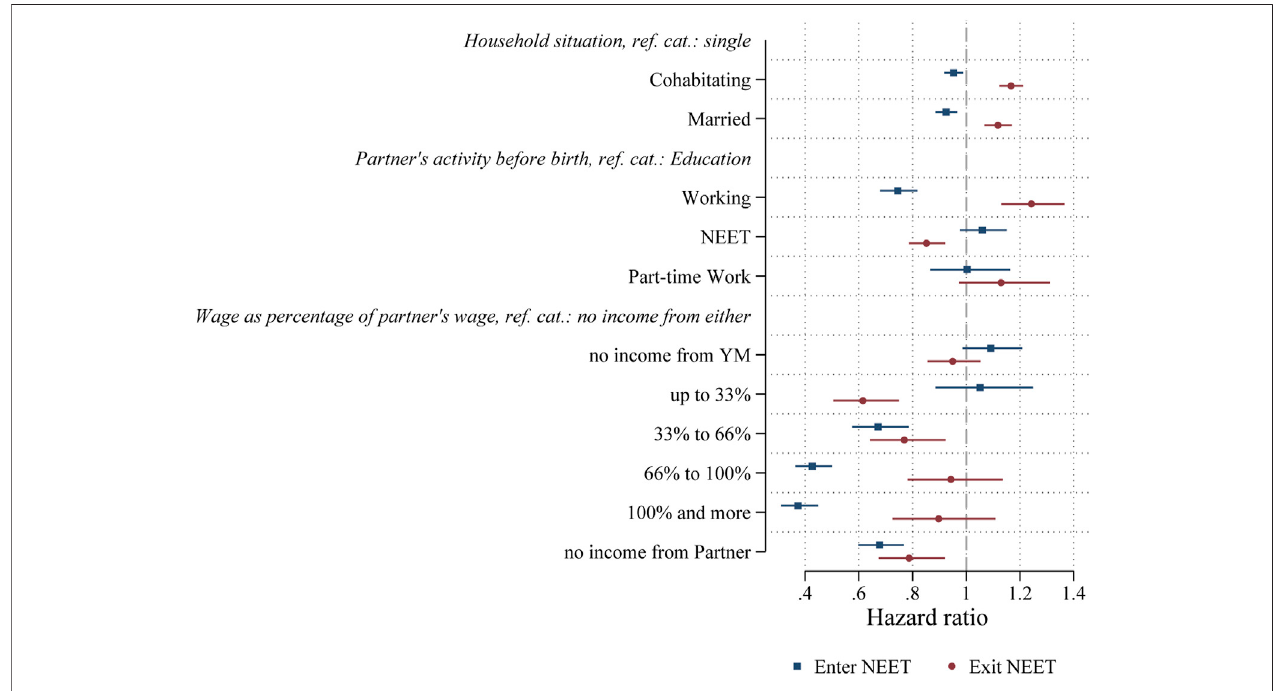
FIGURE 2 | Coef fi cients of partner characteristics from discrete-time event-history analysis (hazard ratios) of entering and exiting NEET.